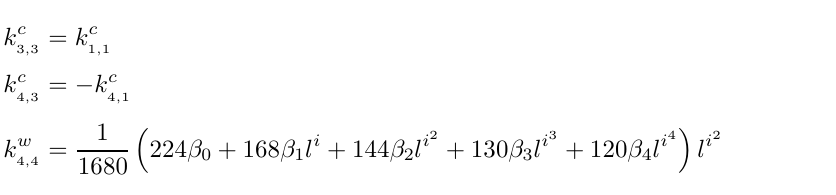
Table A3 Translational mass matrix of rotating tapered Euler-Bernoulli beam